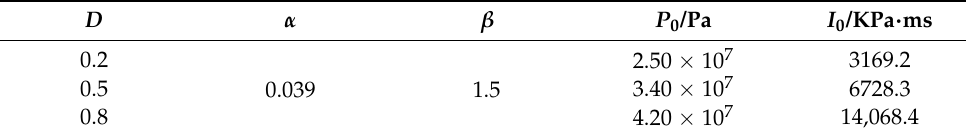
Table 6. Fitted parameter values of P - I curves under 10 MPa geostress.